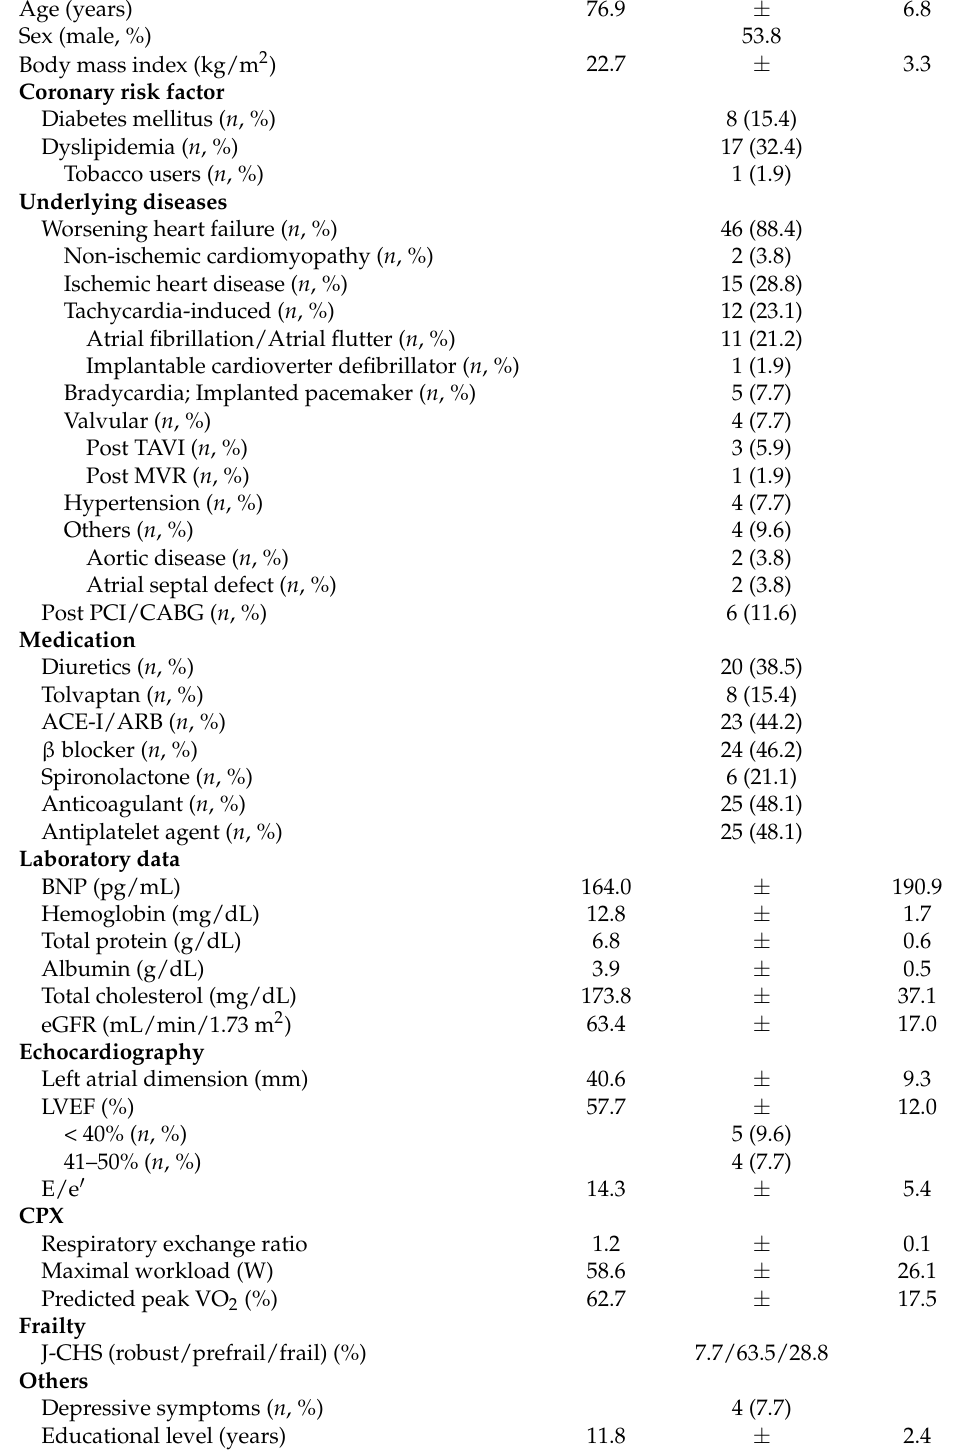
Table 1. Clinical characteristics of study participants ( n =